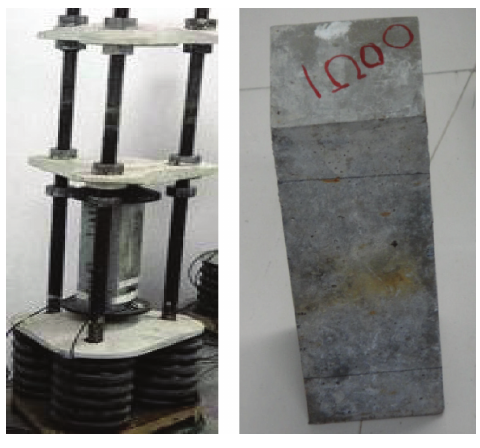
Figure 7: Creep loading test and standard concrete sample.